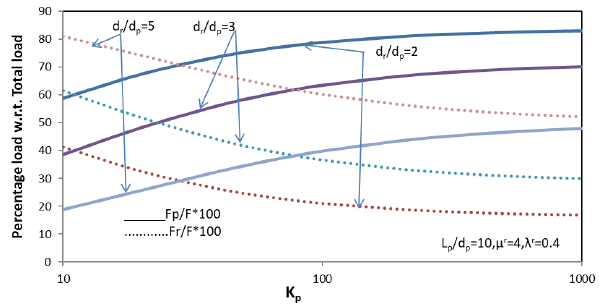
Figure 21: Variation of percentage load w. r. t. total load with the comparative strengthening of GP, K of GP, d /d , on a partially strengthen GP–raft foundation (L r p d =10,μ r =4,λ r =0.4). p